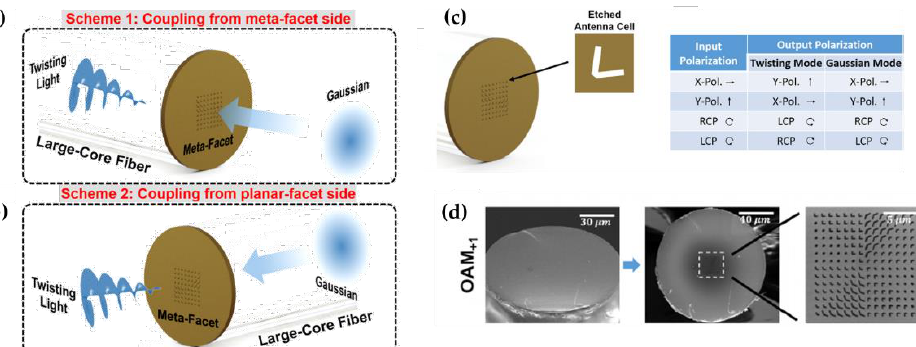
Figure 11. Schematic of the fiber meta-tip for twisting broadband light from either ( a ) meta-facet side or ( b ) planar-facet side. ( c ) Metasurface structure with etched “V-shape” antenna arrays and the conversion relationship between input and output polarization states. ( d ) SEM images of the original fiber facet fabricated on-top metasurface and enlarged metasurface region with OAM +1. Reprinted with permission from Ref. [75] . Copyright 2018, AIP Publishing LLC.